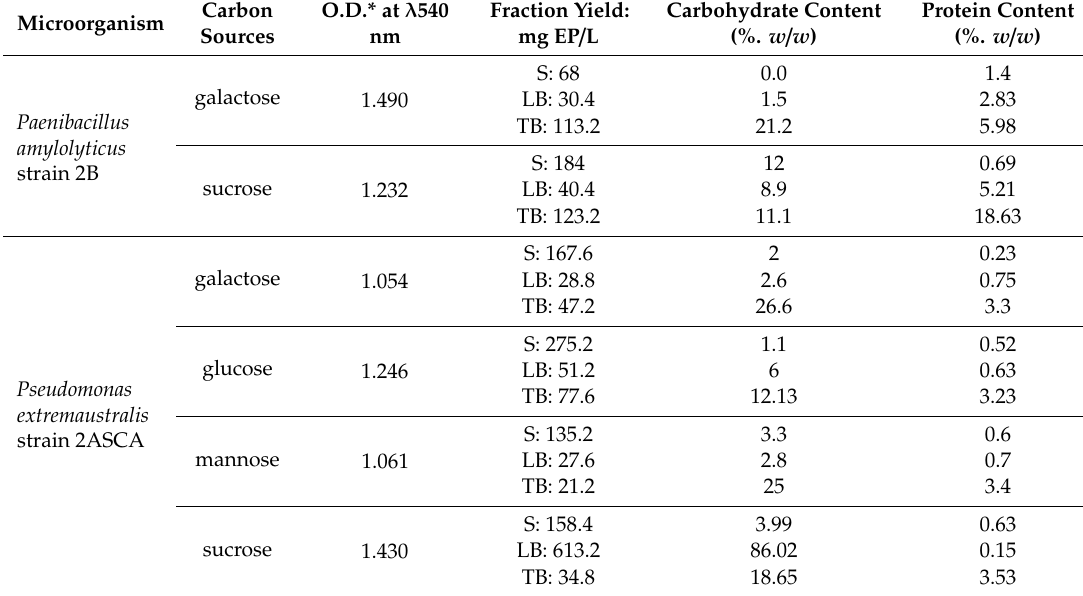
Table 3. Growth and exopolymer yields of Paenibacillus amylolyticus strain 2B and Pseudomonas extremaustralis strain 2ASCA in the presence of single carbon